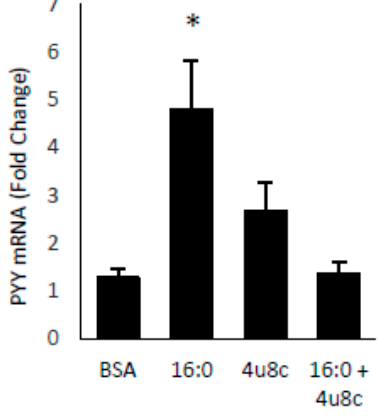
Figure 4. Blocking Xbp1 splicing prevents FFA-induced PYY expression. STC-1 cells were treated